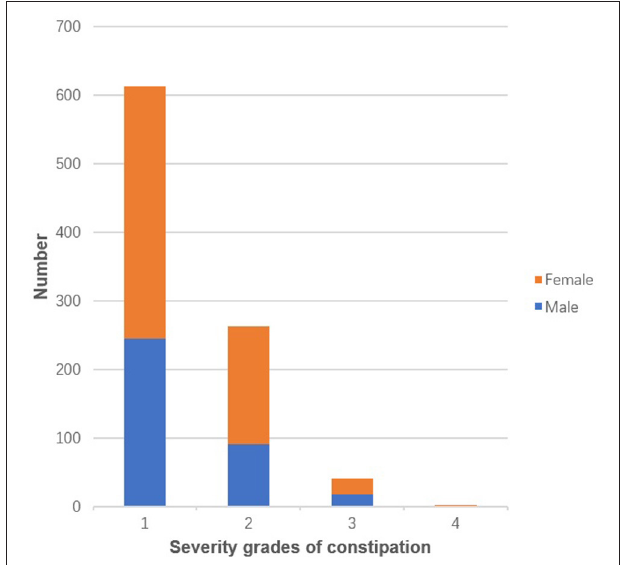
FIGURE 1 | The number of different severity grades of constipation.